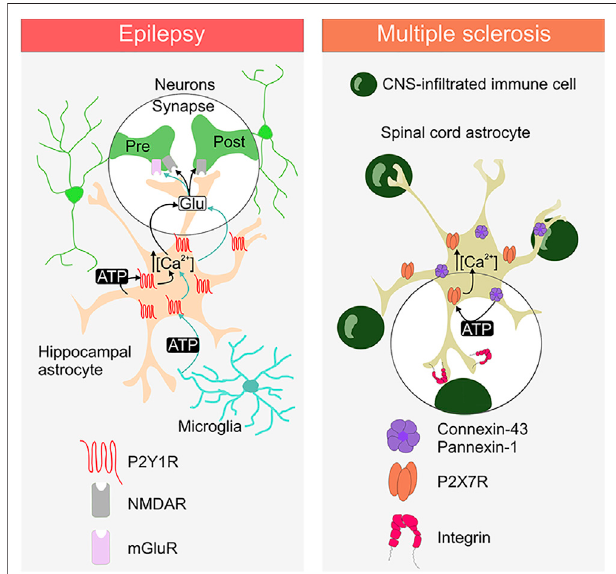
FIGURE1| Purinergicsignallingbetweenastrocytes,neurons,microglia and CNS-in fi ltrated immune cell in epilepsy and multiple sclerosis. The ATP release and the involvement of the speci fi c astrocytic purinergic receptor (PR) type is depicted for the diseases. Activation of astrocytic P2Y1R and P2X7R induce the rise in intracellular Ca 2+ . Activation of P2Y1R promotes the release of glutamate, which acts on the presynaptic and postsynaptic glutamate receptors (NMDAR and mGluR). Activation of P2X7Rs is mediated by the release of ATP through connexin-43 hemichannels and/or pannexin-1 channels. Integrins are depicted as a putative link to the astrocytic P2X7R activation via connexin-43/pannexin-1-derived ATP.